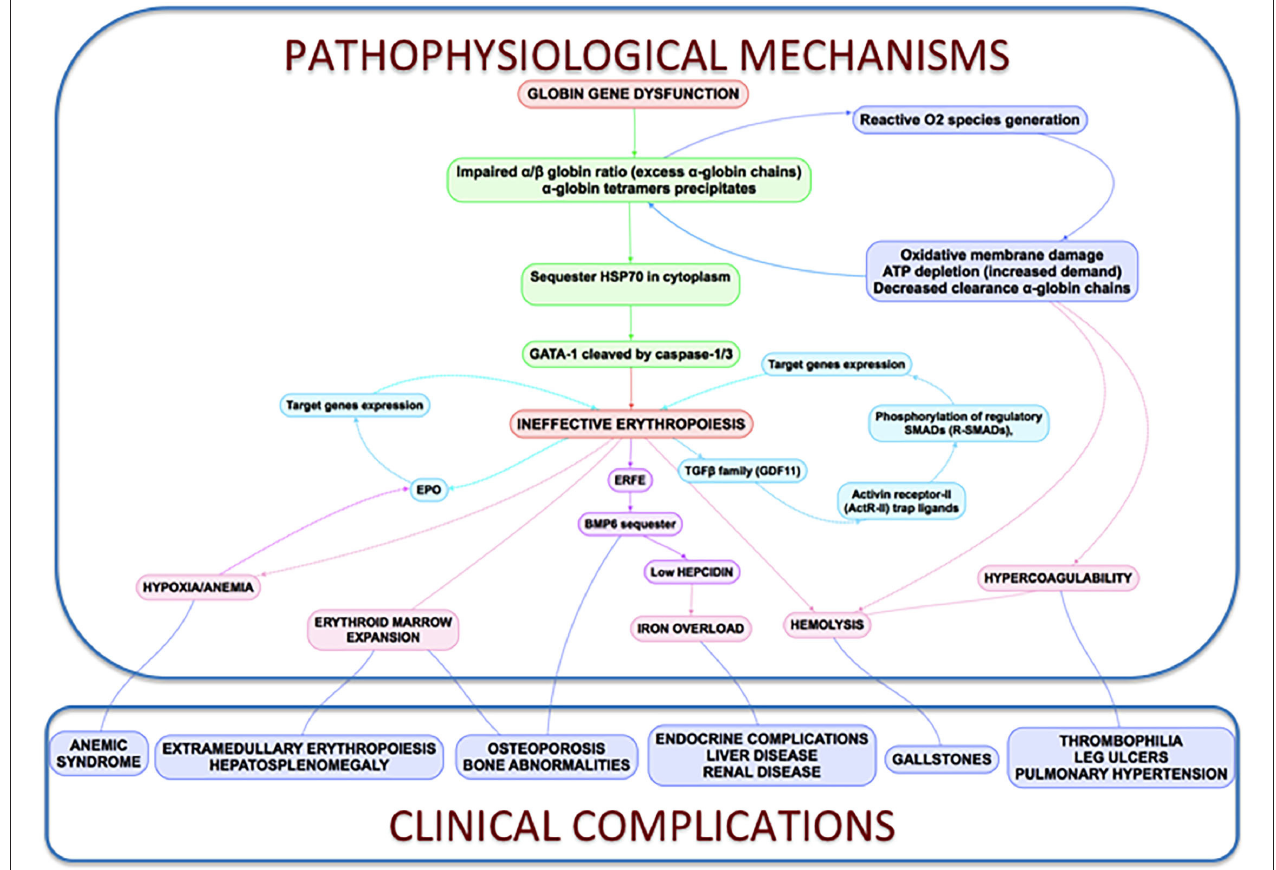
FIGURE 3 | Clinical complications and pathophysiological mechanisms of β -Thalassemia. In thalassemia, the imbalance α / β -globin synthesis is the fundamental initial pathogenic event. Excess α -globin chains precipitate in the cytoplasm, sequester HSP70 and GATA1 is cleaved by Caspase 3/1 which result in dysfunctional erythropoiesis and imposes metabolic stress on the erythrocytes, specifically in the form of excess generation of reactive oxygen species and increased demand on adenosine triphosphate (ATP)-dependent proteolytic mechanisms to clear excess globin chains. These pathophysiological changes lead to the characteristics of this disease: ineffective erythropoiesis, peripheral hemolysis, and subsequent anemia. Clinical implications of the α - and β -globin imbalance include lack of sufficient RBCs and Hb for effective oxygen transport, and ineffective erythropoiesis and hemolysis, which can lead to splenomegaly, bone marrow expansion (extramedullary hematopoiesis), concomitant bone deformities, and iron overload.